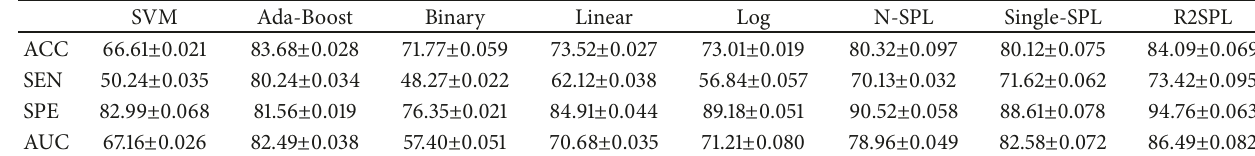
Table 4: Results of seven baselines and our model on the task of MCI versus HC.